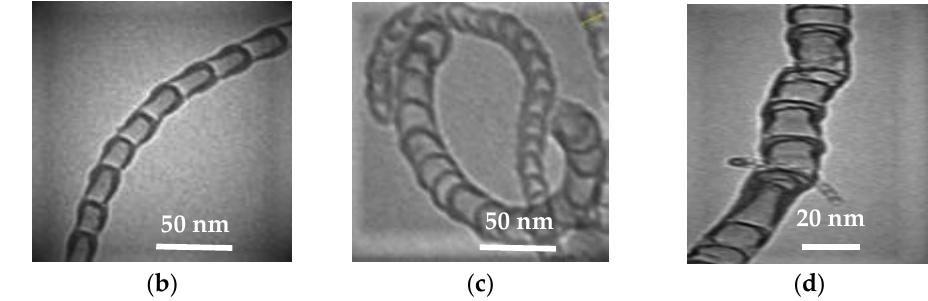
Figure 6. Morphological structures of CNT: ( a ) MWCNT; ( b ) bamboo-like structures; ( c ) spherical sections; ( d ) irregular structures.